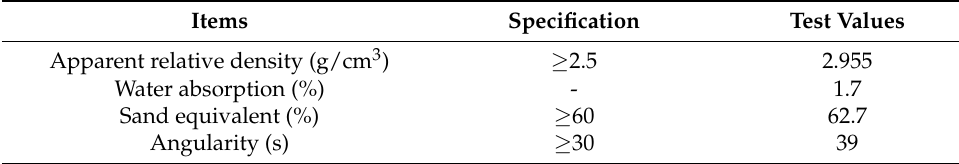
Table 4. Technical indices of the fine aggregates.